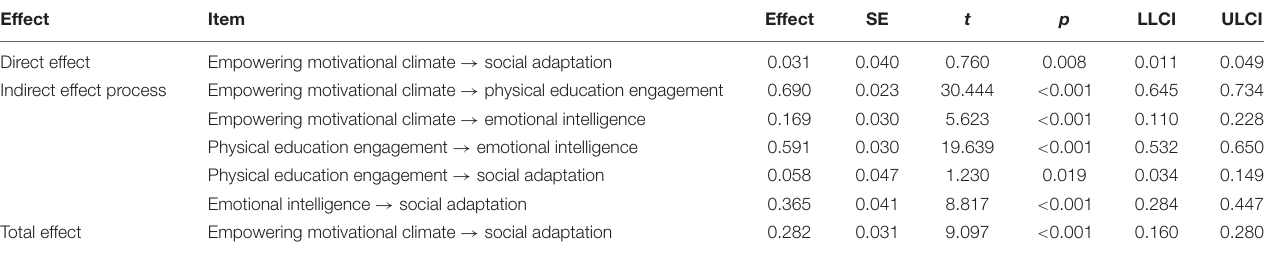
TABLE 2 | Analysis of regression relationship among variables.